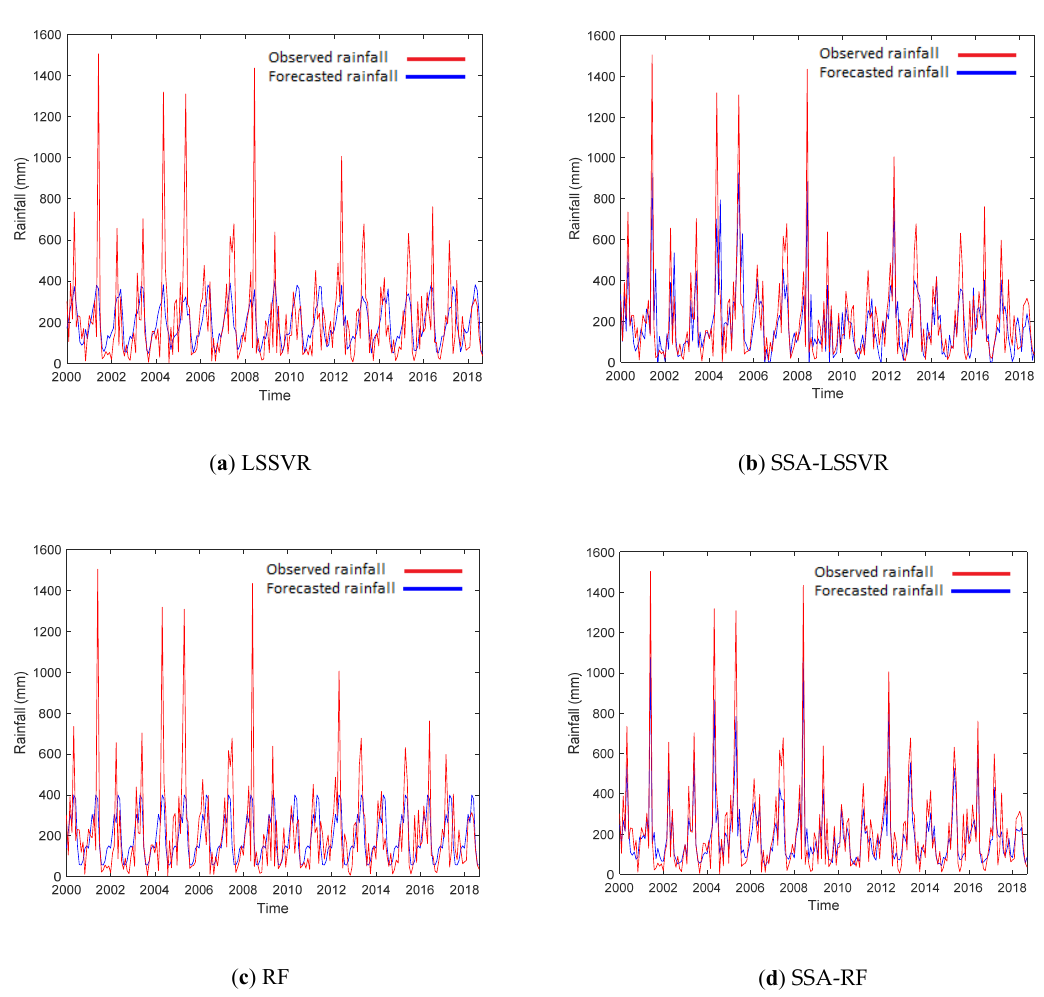
Figure 4. Time-series graphs comparing the observed and forecasted rainfalls by the ( a ) LS-SVR, ( b ) SSA-LSSVR, ( c ) RF, and ( d ) SSA-RF models for Shihmen Reservoir watershed 1-month lead time.